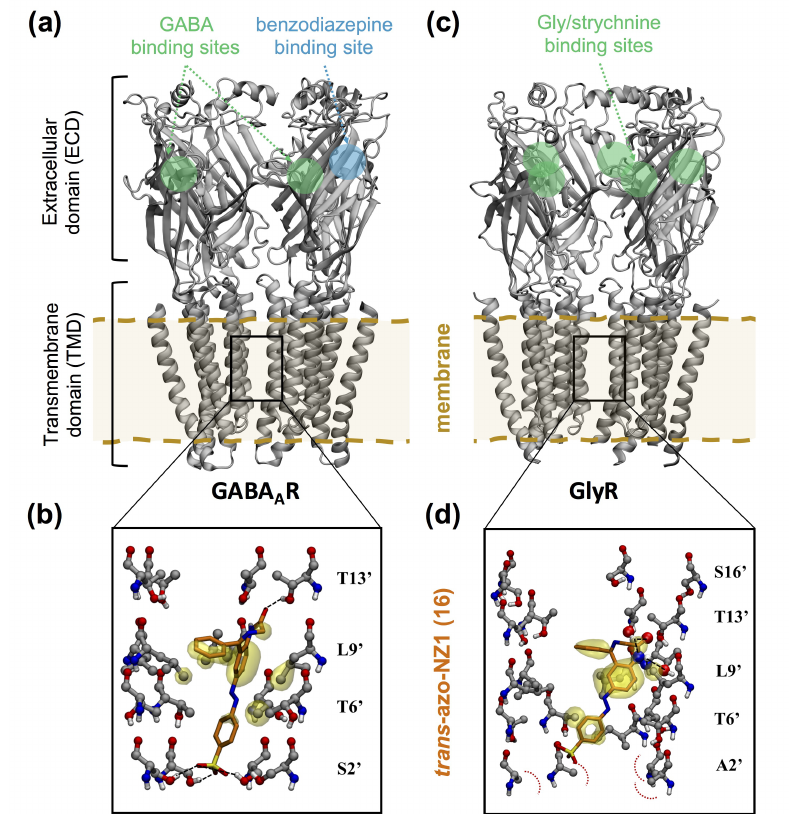
Figure 7. Computational models of the pore blocker trans -azo-NZ1 bound to γ -aminobutyric acid type A (GABA A ) and Gly receptors. ( a ) Computational model of α 1 β 2 γ 2 GABA A R in complex with GABA [105]. The orthosteric GABA binding sites and the allosteric benzodiazepine binding site in the ECD are indicated with green and blue circles, respectively. For the sake of clarity, the front subunit of the heteropentamer is not shown. ( b ) Docking pose of trans -azo-NZ1 in the GABA A R- ρ 2 pore. Pore-lining residues are labeled according to the generalized numbering of the M2 helix residues for pLGICs. Hydrophobic interactions between azo-NZ1 and the receptor residues are marked as yellow transparent surfaces, hydrogen bond interactions and steric repulsion are represented with black and red dashed lines, respectively. Adapted from reference [103] with permission (CC-BY NC license) from the British Journal of Pharmacology, published by John Wiley and Sons (2019). ( c ) Cryo-EM structure of GlyR in complex with strychnine [109], a competitive antagonist that binds to the glycine neurotransmitter site, whose location is indicated with a green circle. For the sake of clarity, the front subunit is not shown. ( d ) Docking pose of trans -azo-NZ1 in the G2’A α 1 GlyR pore. Interactions are displayed following the same representation as in panel ( b ). Adapted from reference [110] with permission (CC-BY license) from eNeuro, published by the Society for Neuroscience